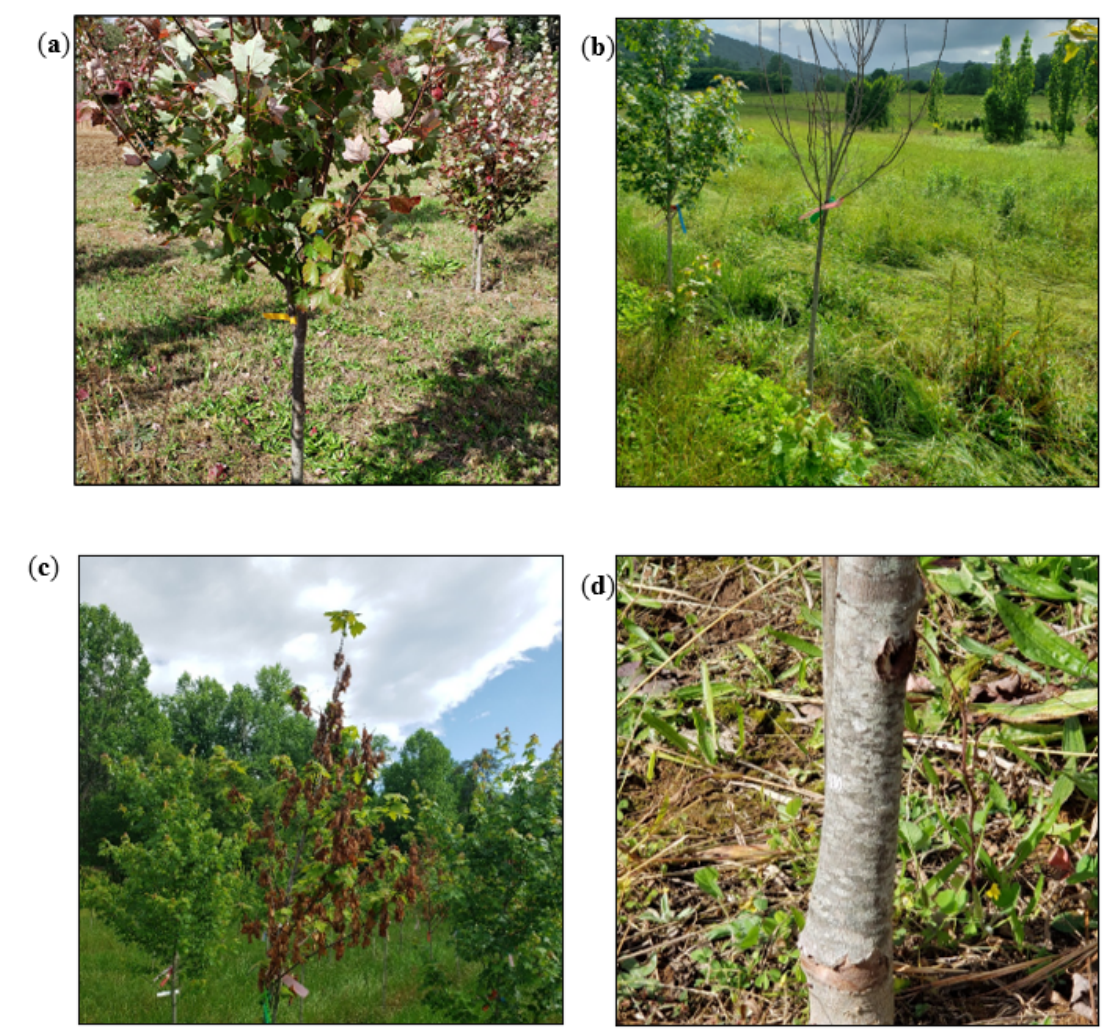
Figure 1. Stress treatments applied to red maple ( Acer rubrum) cultivars. Photographs are of ‘Frank’s red’ cultivars at the Moore Nursery in Irvine College, TN, USA, but ‘Brandywine’ cultivars at the Otis Floyd Nursery Research Center, McMinnville, TN, USA received the same treatments. ( a ) control treatment with no stress application. ( b ) complete mechanical defoliation of tree canopy. ( c ) complete chemical defoliation with a foliar contact herbicide. ( d ) girdling of the sapling trunk.